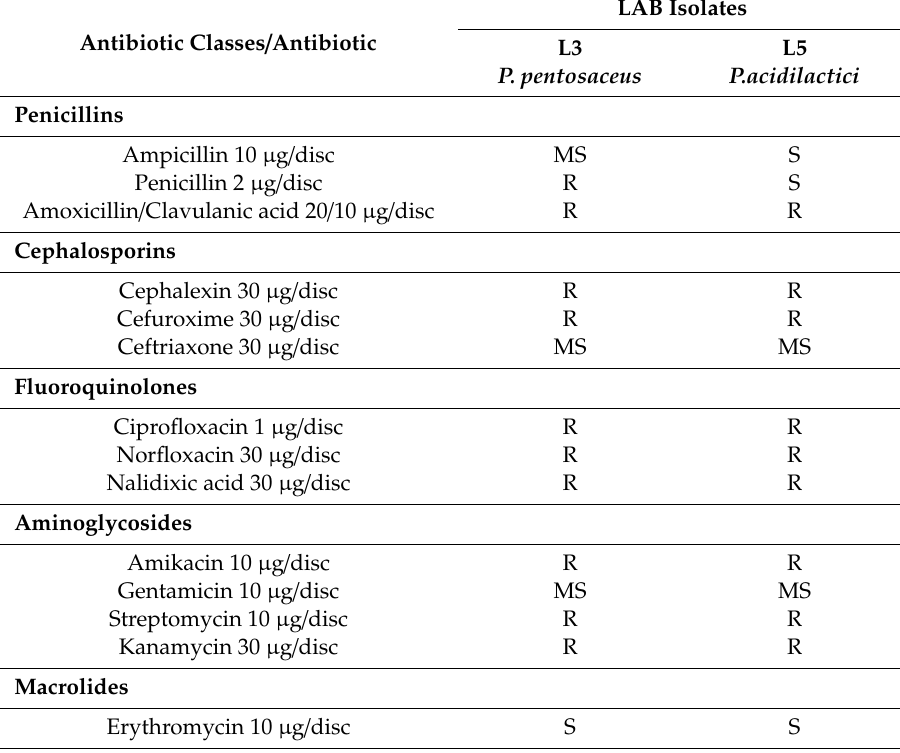
Table 3. Antibiotic susceptibility of LAB strains of Pediococcus spp. isolated from industrial Kombucha.